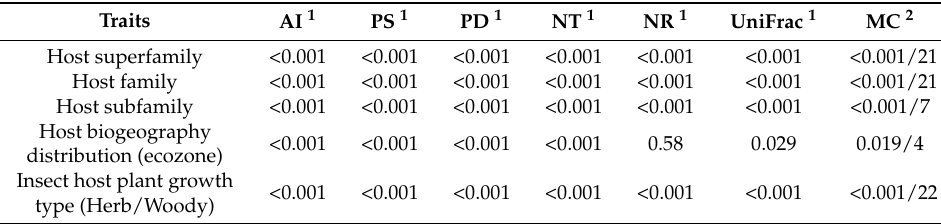
Table 1. Phylogeny-trait correlations estimated under different statistical